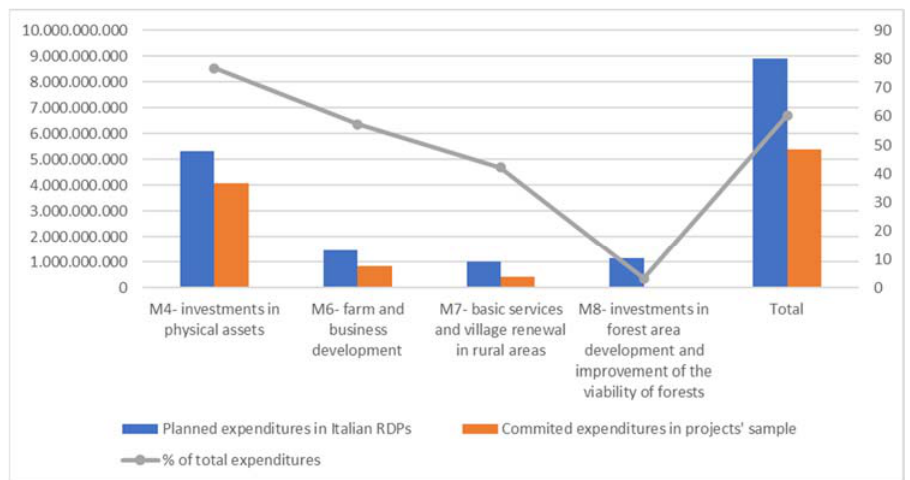
Figure 6. Investment committed expenditures (EUR), compared to RDPs’ planned expenditures. Source: authors’ elaborations from the data base of funded investment projects.